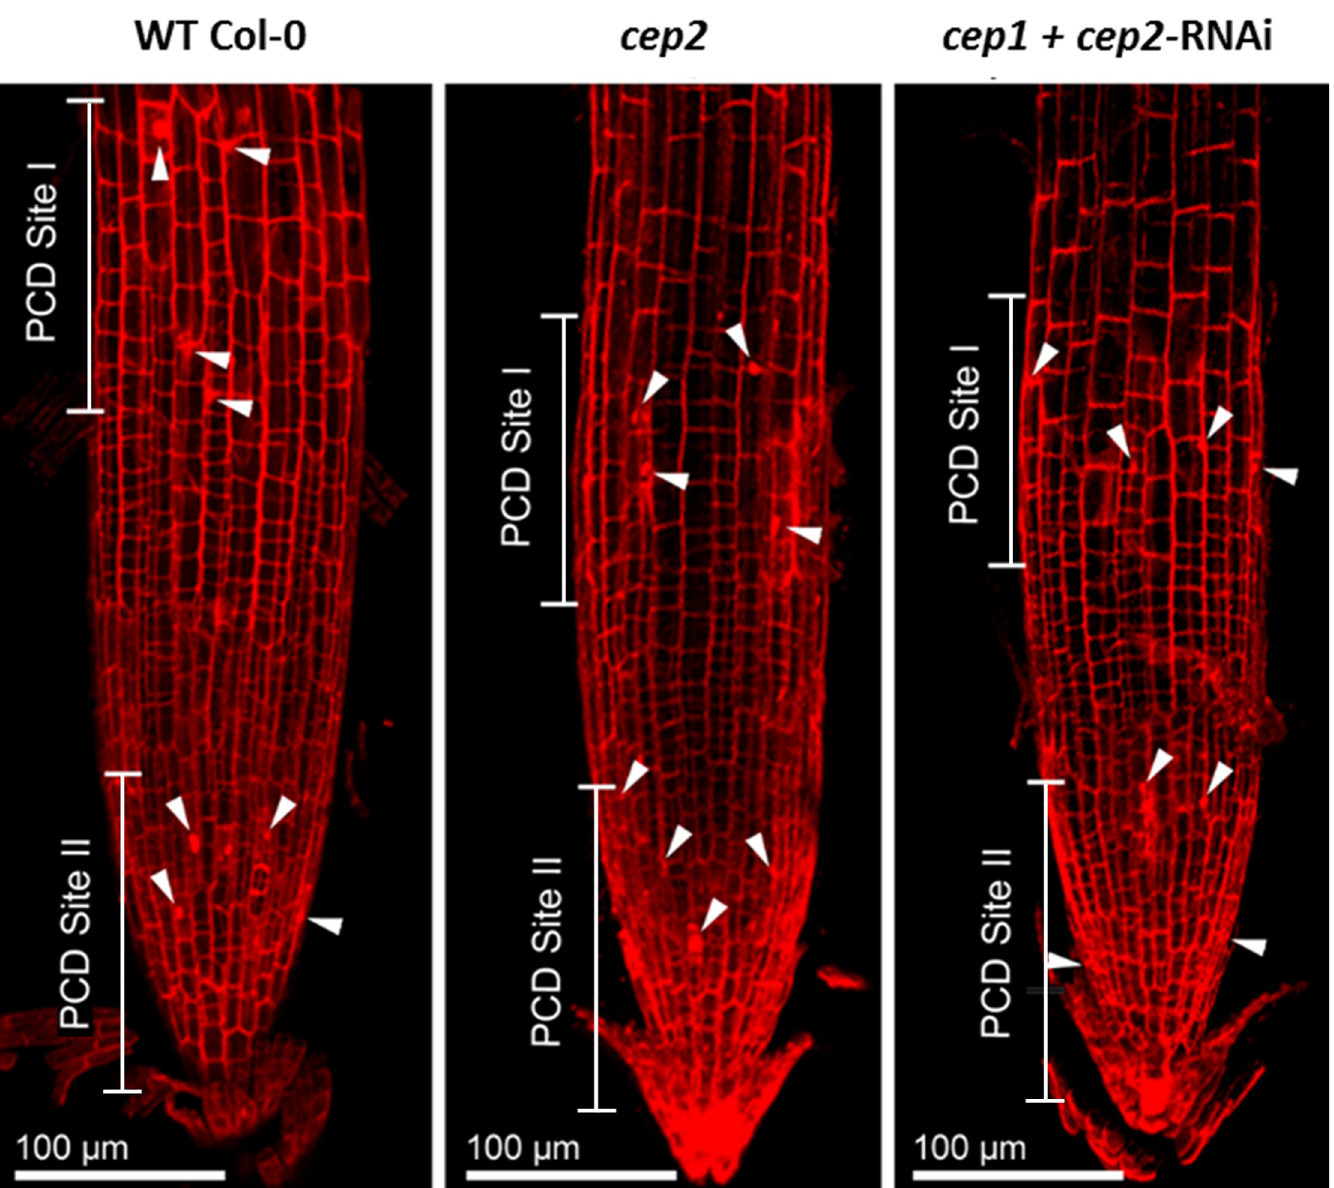
Fig 5. CEP2 loss of function does not impair PCD in the LRC, although the PCD site I is shifted more close to the root tip in cep2 ko mutants due to the reduced cell lengh of the LRC and again to a lesser extent in cep1 cep2 double ko/kd mutants as compared to WT plants. 7 days old seedlings of WT, cep2 ko and cep1 cep2 double ko/kd mutants ( cep1 + cep2- RNAi) were stained with propidium iodide and analyzed by CLSM (stack of 14 optical sections, 200-fold magnification). PCD site I and II are indicated by nuclei stained with propidium iodide (arrow heads) thus indicating cells approaching PCD since their cell membranes become permeable to propidium